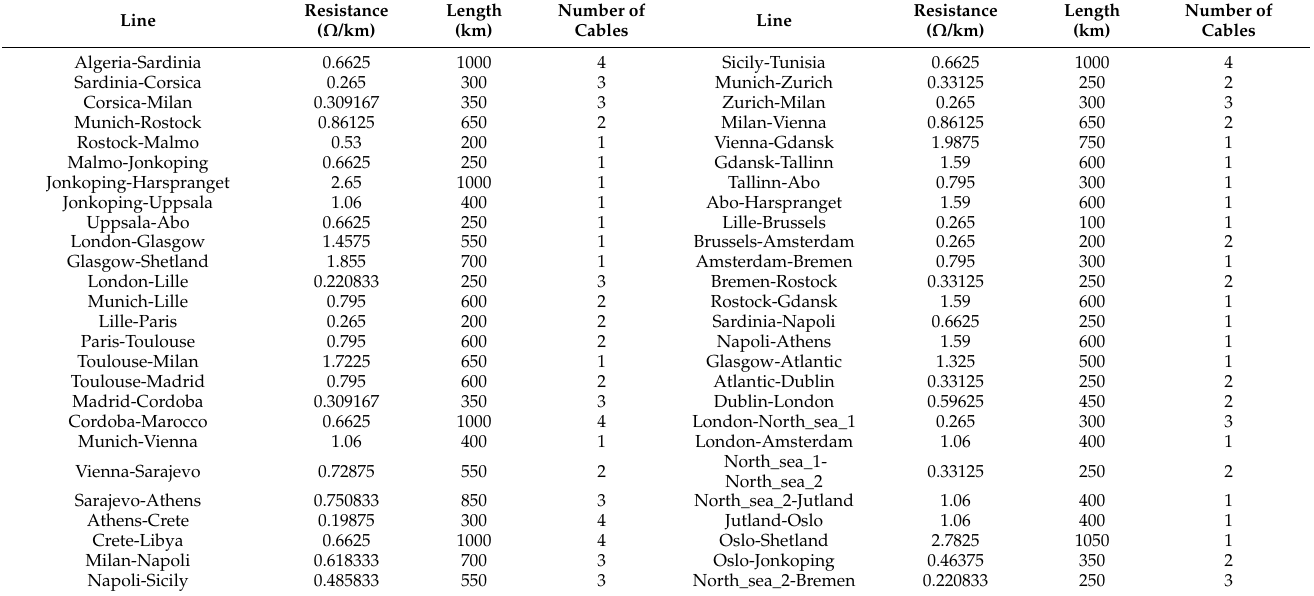
Table A3. DC lines information.